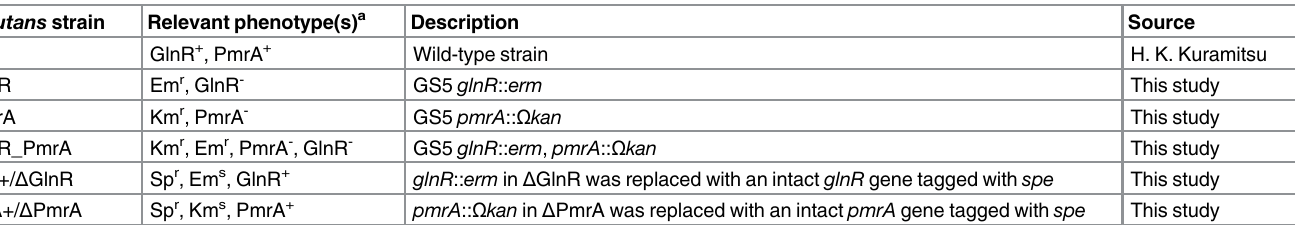
Table 1. Bacterial strains used in this